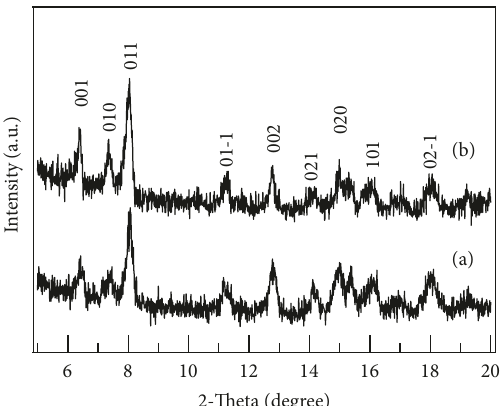
Figure 3: XRD patterns of Alq 3 microbelts on the one-step (a) and two-step (b) APA surface. The crystals were formed by treating the APA samples in a 10mM HQ solution at 100 ∘ C for 3min.